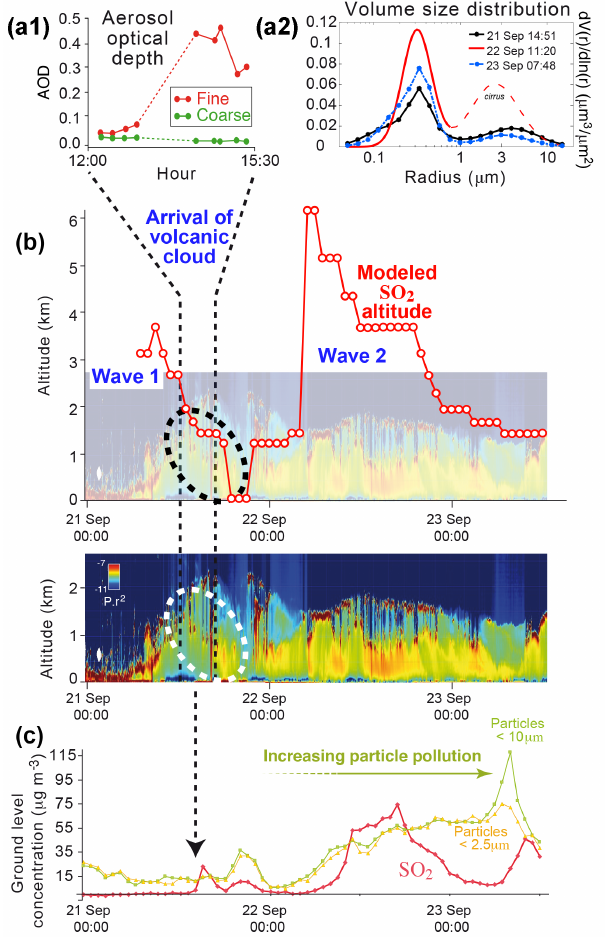
Figure 7. Multi-parametric observations and modelling of SO 2 and aerosols in Lille: (a) retrieval of sunphotometric observations yields (a1) aerosol optical depth (at 500nm) for coarse (green) and fine (red) mode on 21 September and (a2) time variations of aerosol volume size distribution. (b) Time series of the modelled altitude (red line) of the most concentrated layer of volcanic SO 2 overlaid on the lidar range-corrected backscatter signal (ln (P × r 2 ) ) at 532nm. Distinction between aerosol and meteorological clouds in lidar data is shown in Fig. 2. (c) Ground-level concentration of SO 2 (red) and particles (PM 2 . 5 in yellow and PM 10 in